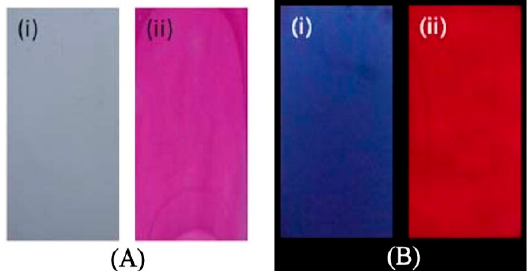
Figure 7. ( A ) Photographs of TLC plates after the immersion of molecular probe 20 into a MeOH solution ( i ) after the addition of Cd 2 + ions ( ii ) under ambient light; and ( B ) under hand-held UV-light at solution ( i ) after the addition of Cd 2+ ions ( ii ) under ambient light; and ( B ) under hand-held UV-light 365 nm, ( i ) after the addition of Cd 2 + ions, ( ii ) under hand-held UV-light at 365 nm, Adapted from [172], at 365 nm, ( i ) after the addition of Cd 2+ ions, ( ii ) under hand-held UV-light at 365 nm, Adapted from with permission from American Chemical [172], with permission from American Chemical Society.